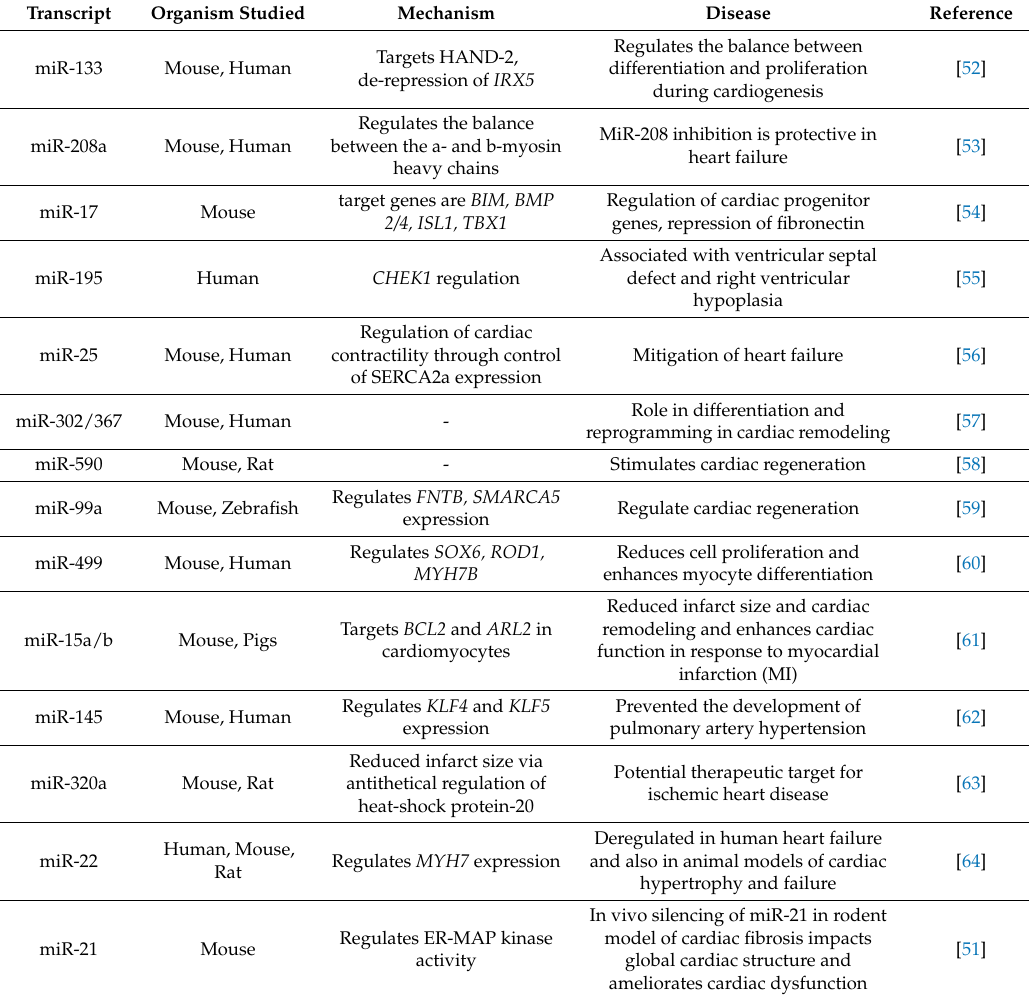
Table 2. List of clinically relevant miRNA in cardiovascular